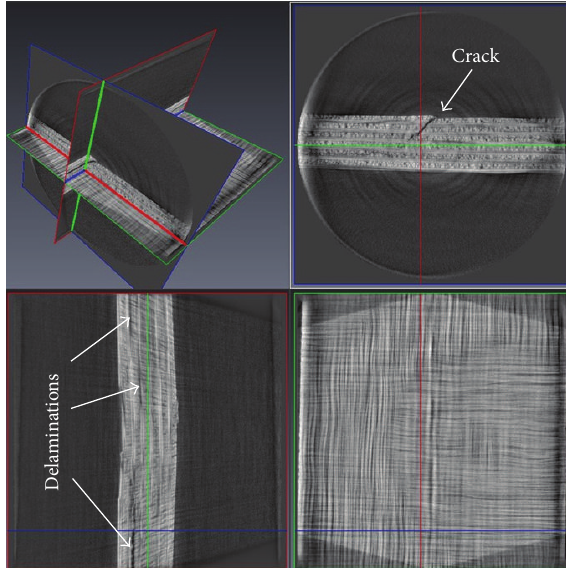
Figure 13: A cross-section of the impacted UD laminate showing a largethrough-thicknesscrackandcleardelaminationsites.Asimilar crack was observed in all test repeats for this material.